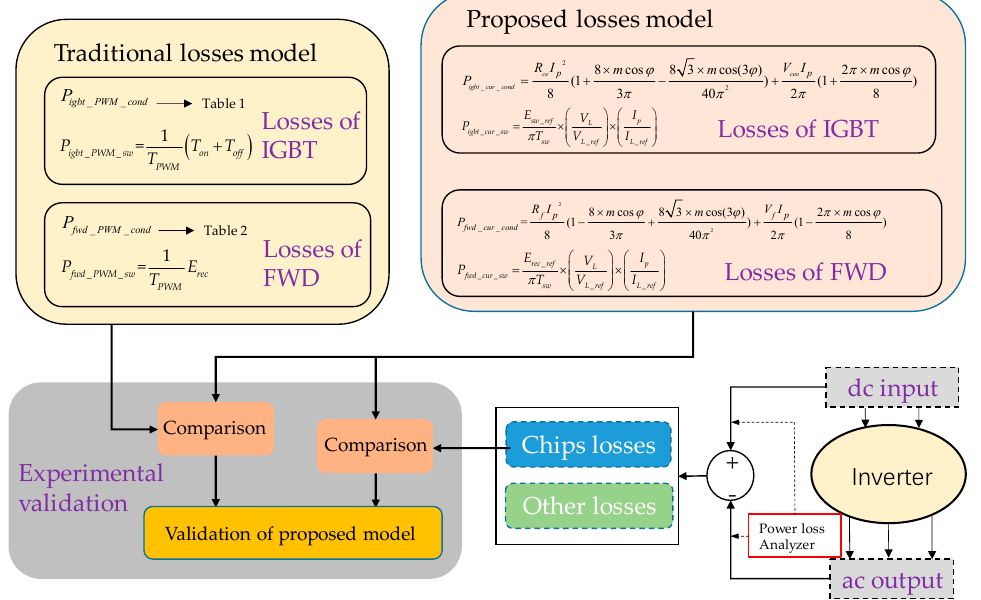
Figure 10. Two experimental validation strategies.